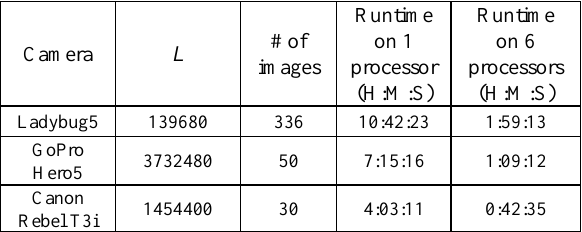
Table 3. Run-time of experiments using different numbers of processors